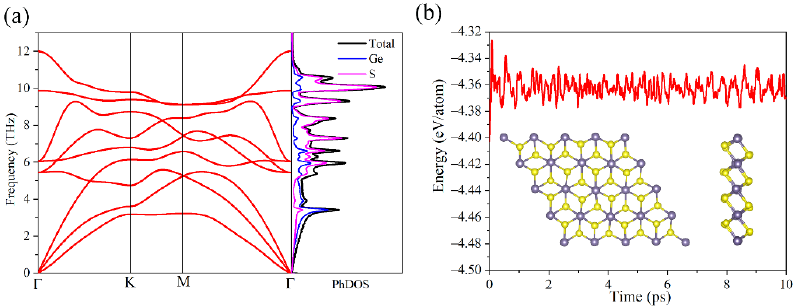
Figure 2. The ( a ) phonon spectrum and PhDOS of GeS 2 monolayer and ( b ) total energies evolution and structure snapshots after 10 ps AIMD simulations at 300 K for GeS 2 monolayer.